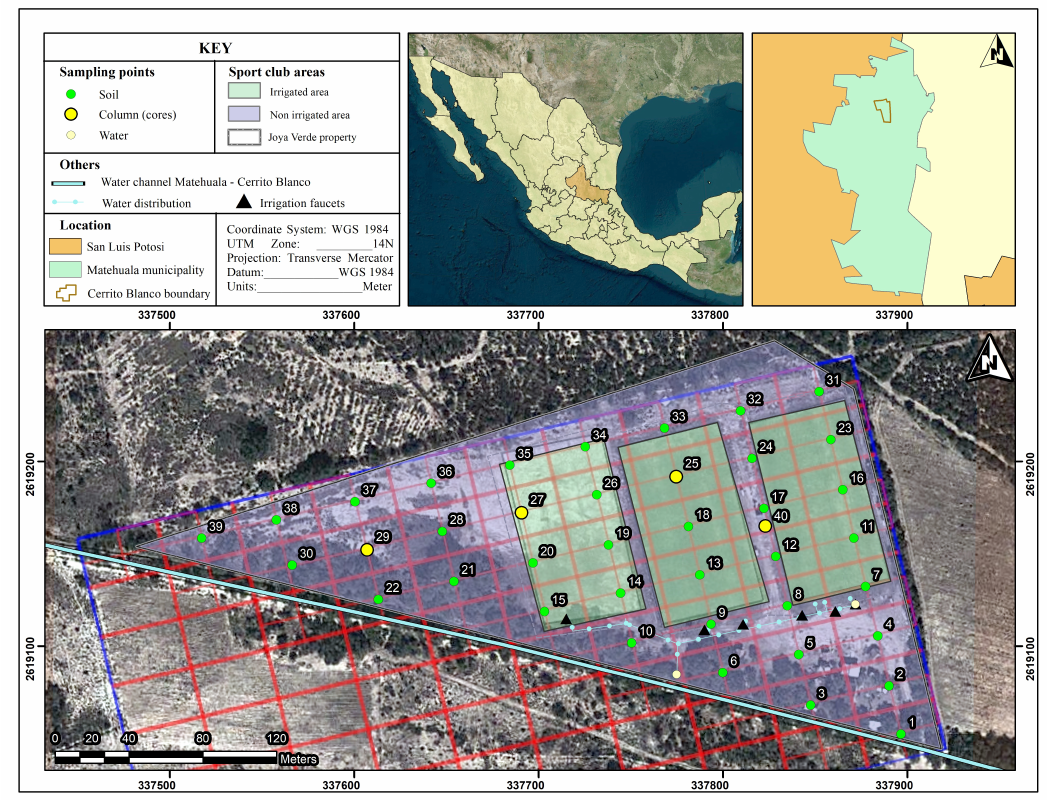
Figure 2. Site and sampling